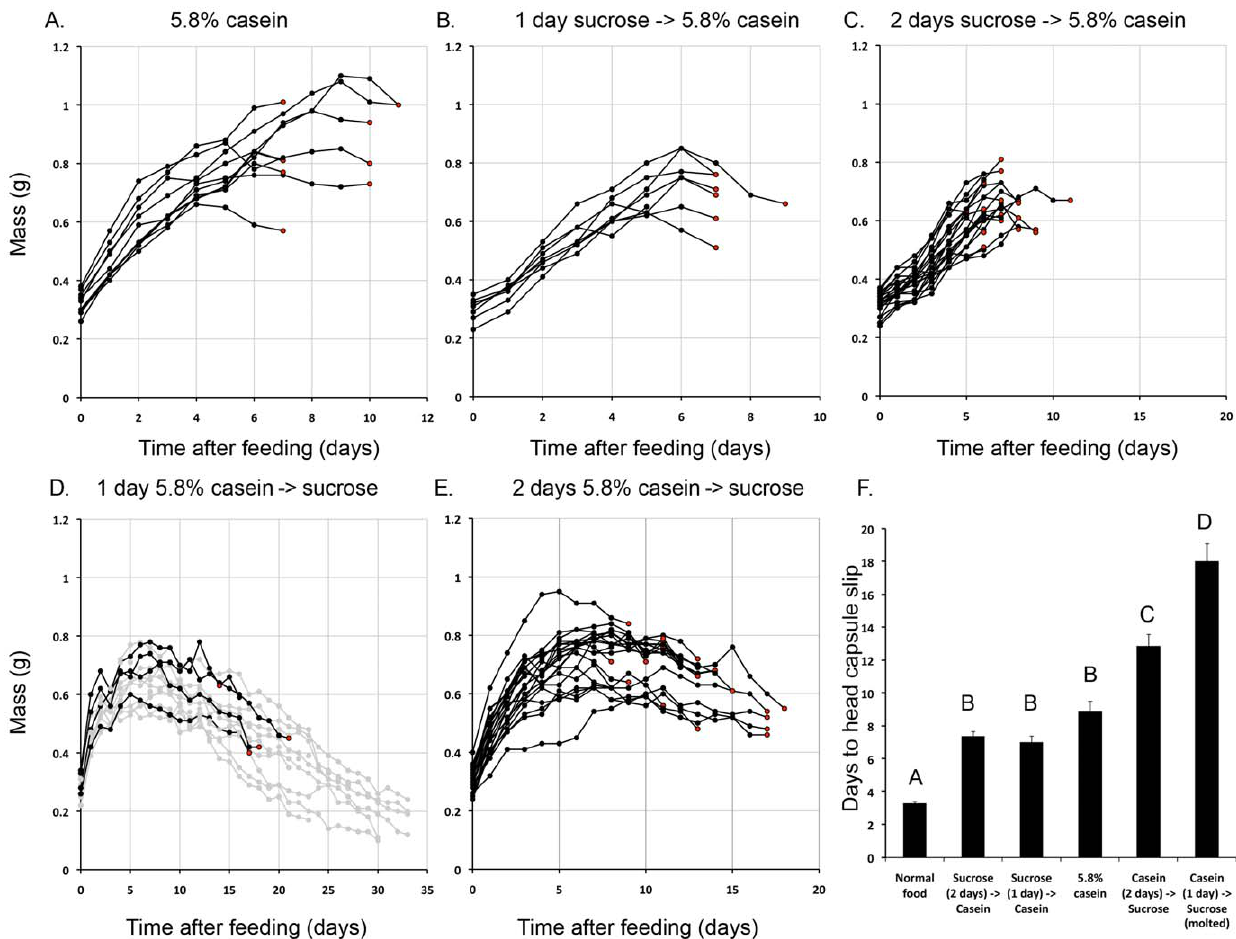
Figure 2. Growth of fourth instar M.sexta larvae transferred from sucrose to casein diets and vice versa. (A–E) Growth trajectory of fourth instar larvae transferred from sucrose to casein diets and vice versa. Day 0 larvae were fed 5.8% casein and 7% sucrose in the specified order, and their growth trajectory was monitored. The red dots indicate the timing of head capsule slippage (n=8–20 for each treatment). Black circles indicate the animals that molted whereas grey circles represent the animals that ultimately died without molting. (F) The time taken for larvae to initiate a molt. Different letters represent statistically significant differences (ANOVA with Tukey-Kramer HSD test; p , 0.05; n=4–20). p , 0.0001 for all statistically different pairwise comparisons except between larvae fed on casein for either one or two days and transferred to sucrose (p=0.0002), and between those fed on normal diet and those fed on sucrose for one day followed by casein (p=0.0008). Error bars represent standard errors.